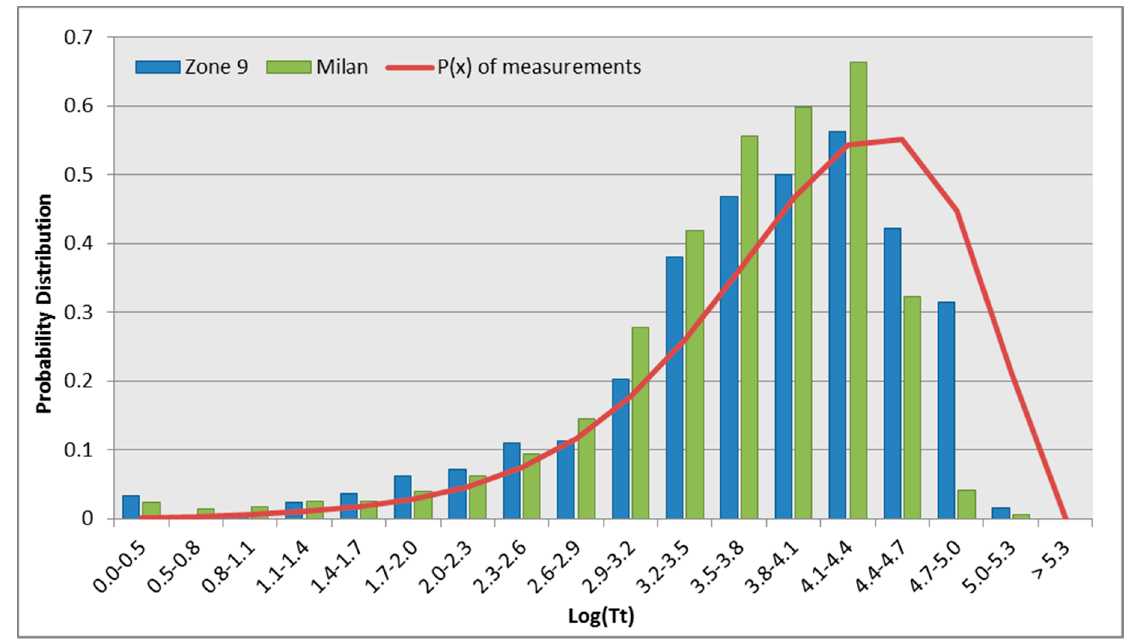
Figure 5. Distribution function P ( x ) of x = Log(T T ) for Zone 9 of Milan City (Blue Histogram), compared to the distribution of x for the entire city of Milan (Green Histogram). The continuous line represents the same fitting procedure as in Figure 4, from the 93 road stretches where the noise measurements were performed.